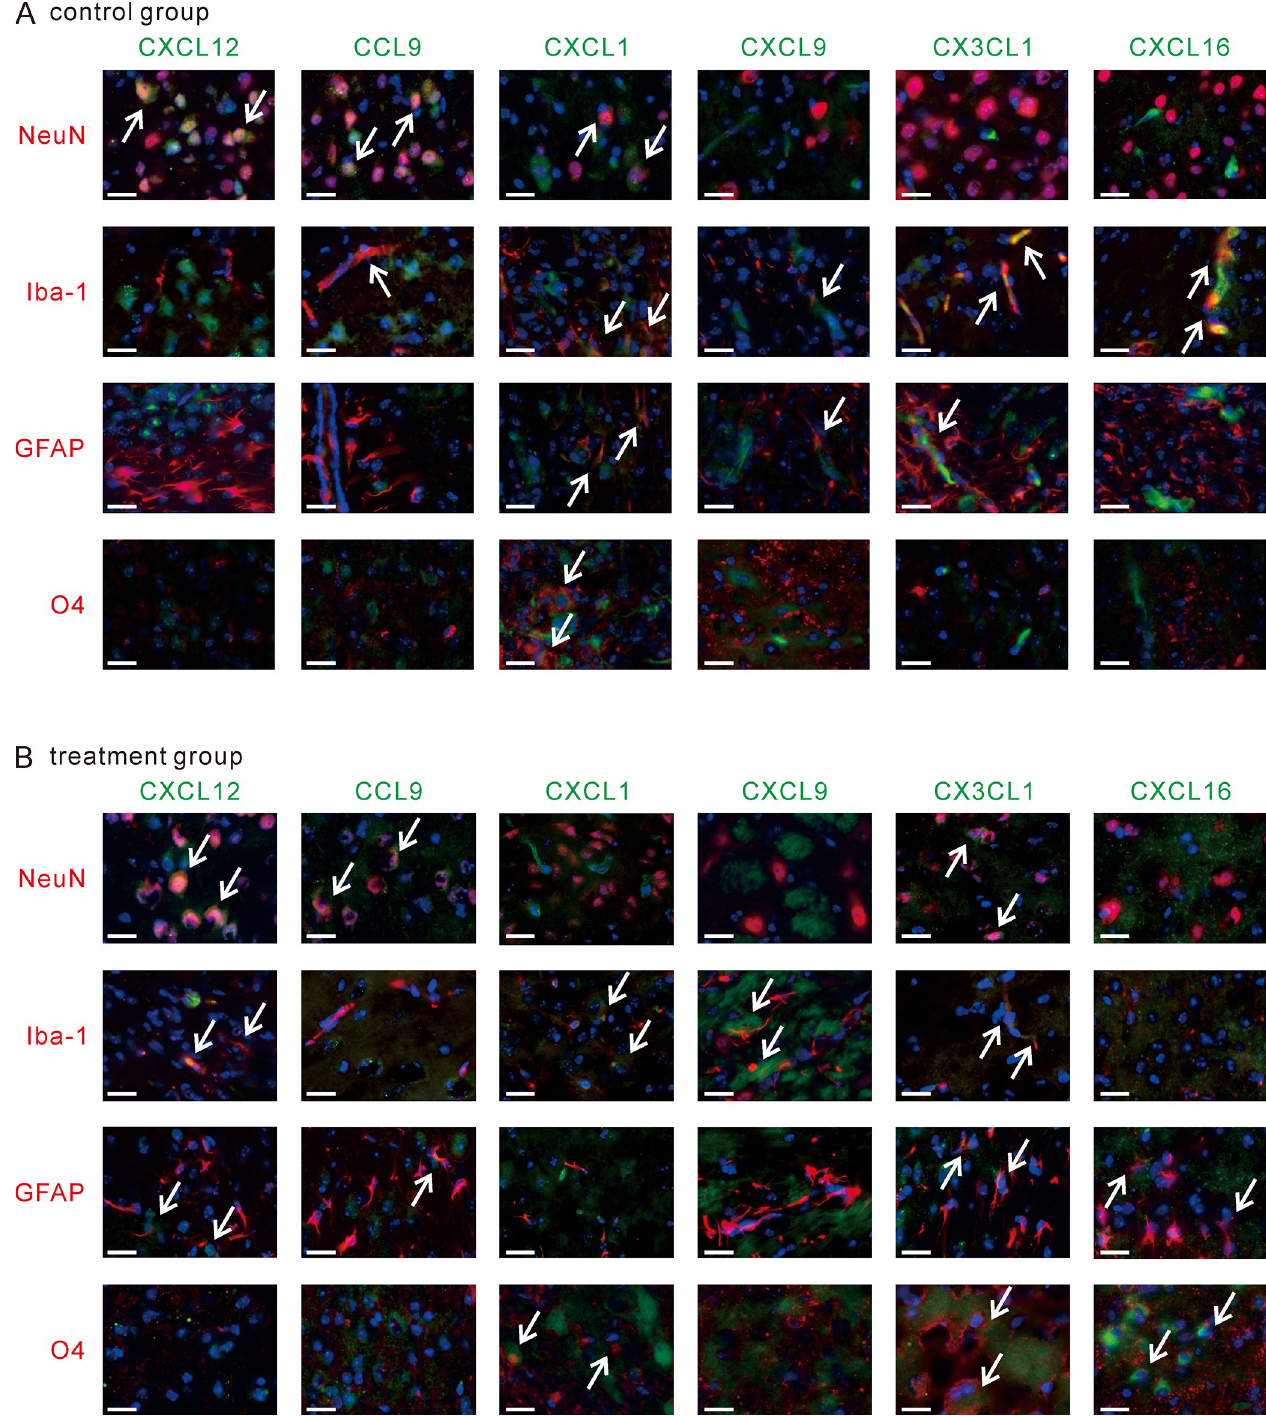
Fig 6. Brain composing cells were the source of chemokines. (A, B) Brain tissue sections at 1 week post-IR in the control group (A) or 5 weeks post-IR in the hUCB cell treatment group (B) were immunohistochemically stained for chemokines and brain cellular markers. Chemokines are shown in green, and cell markers are shown in red. Counterstaining with DAPI (in blue) was also performed, and merged images are shown to allow visualization of co-expressed chemokines and cell markers. Arrows indicate co-expression signals. Bars = 20 μ m. Data are one of representative observations.